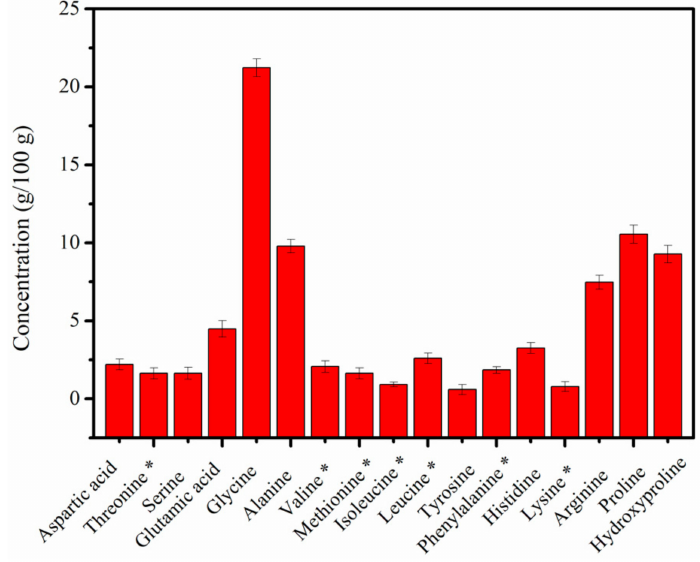
Figure 2. Amino acids content of MCPs extracted from skin of Nibea japonica . Note: * essential amino acid. All assays were performed in